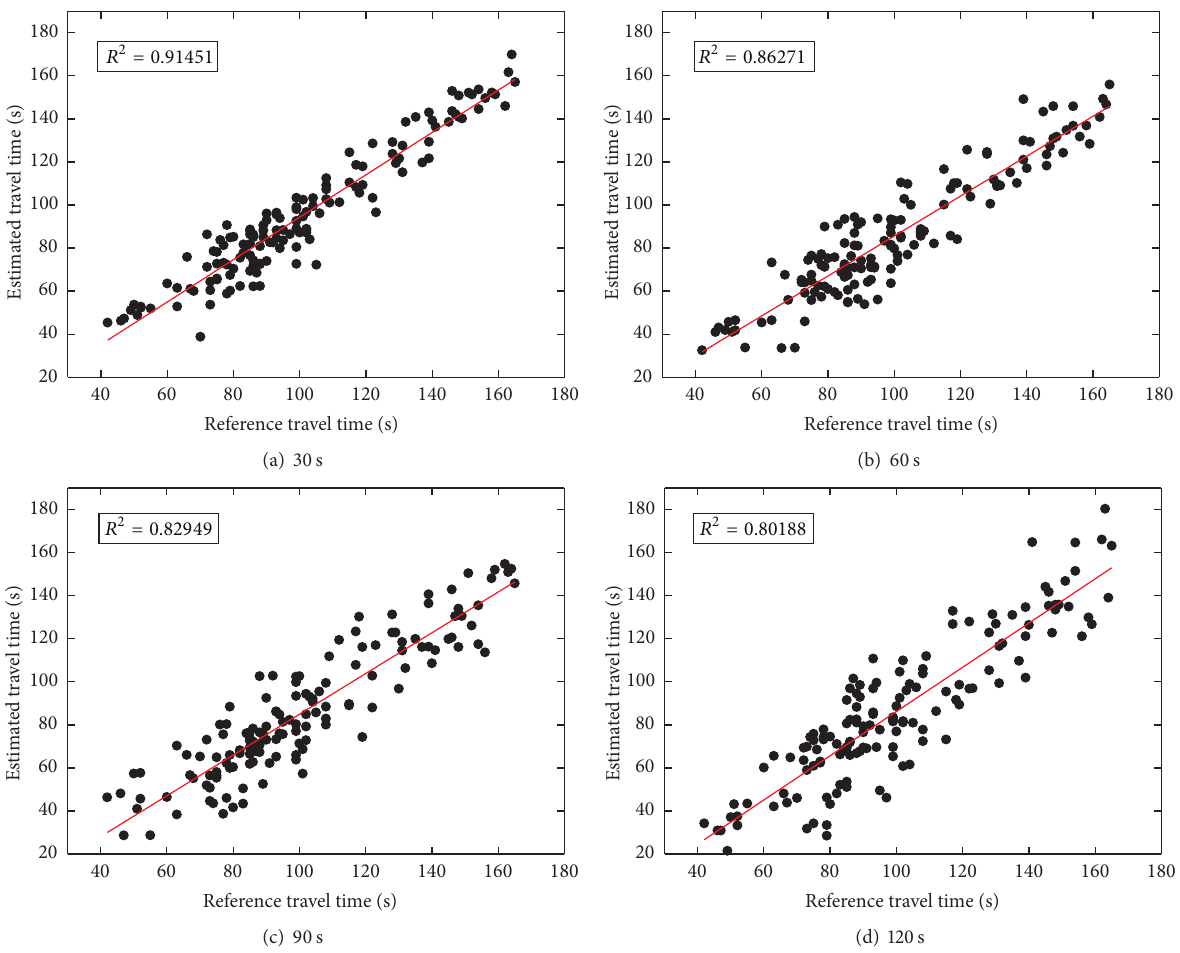
Figure 8: Correlation between estimated link travel times and reference travel times based on the spatiotemporal moving average method at different sampling frequencies.